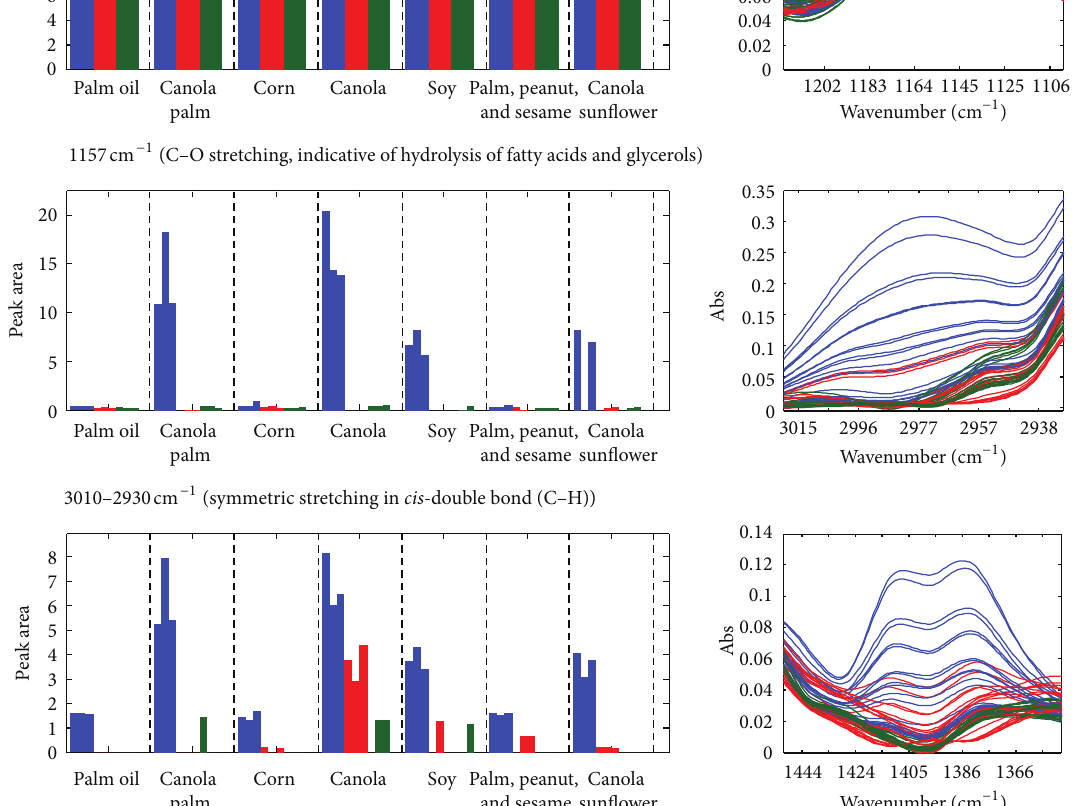
Figure 4: The relative abundance of some discriminatory bands of FTIR spectra with blue, red, and green bars indicating unheated samples and samples heated at 100 ∘ C and 150 ∘ C,